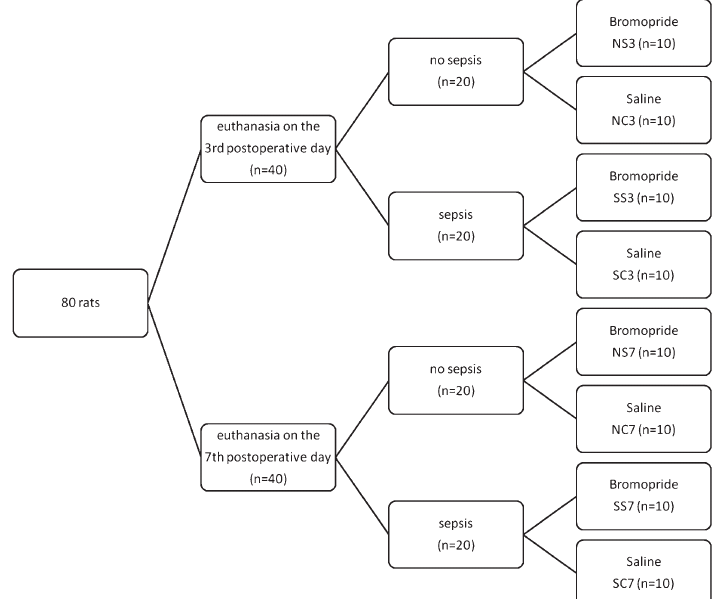
Figure 1. Allocation of animals to groups and